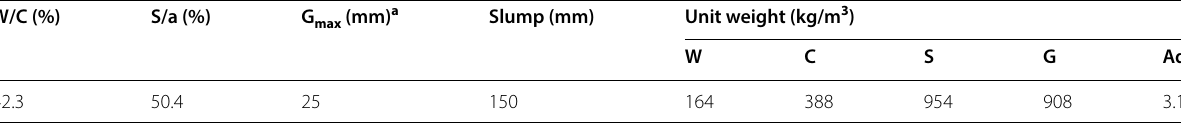
Table 3 Mixture design of concrete used.